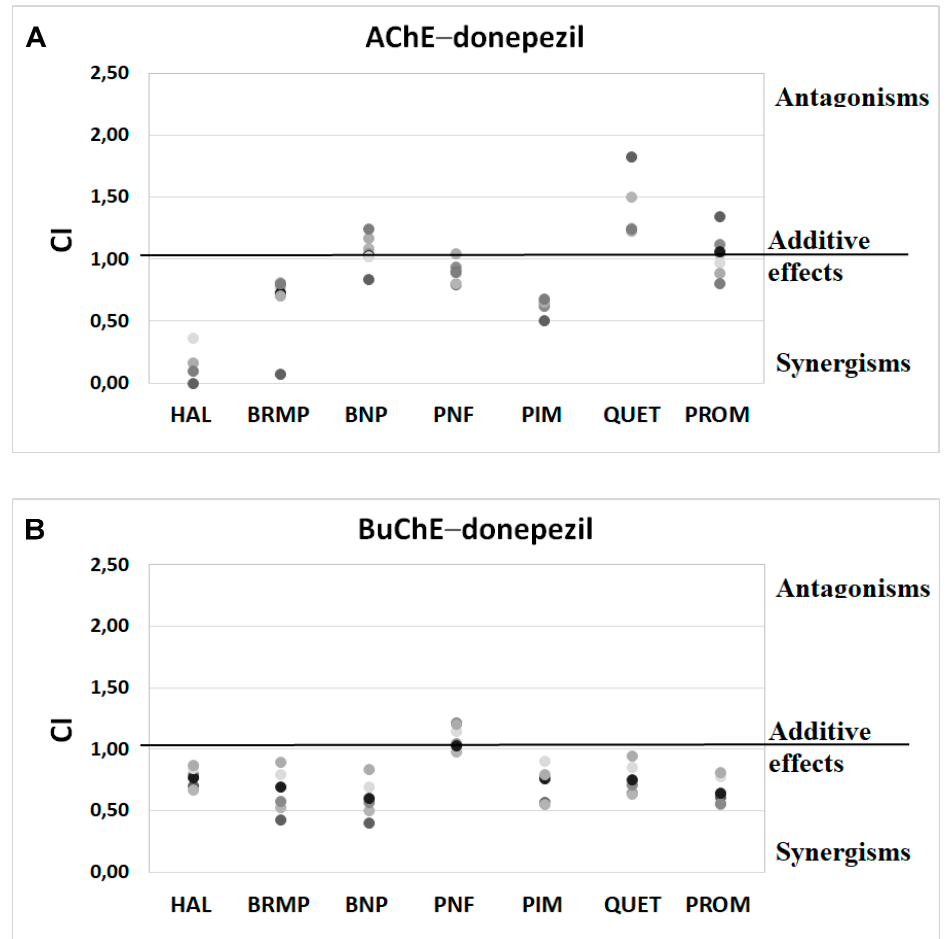
Figure 4. Analysis of potential synergism between donepezil (DON) and haloperidol (HAL), bromperidol (BRMP), benperidol (BNP), penfluridol (PNF), pimozide (PIM), quetiapine (QUET) and promazine (PROM) with the application of the median–effect principle. Data from an AChE ( A ) and BuChE ( B ) inhibitory activities assay were analyzed with the Chou–Talalay method. Results are presented as CI values determined with ComboSyn software for binary mixtures with variable concentration of donepezil (range 0.005–0.1 µmol/L for AChE and 2–100 for BuChE) and constant concentration of antipsychotic (at their TPC max ). The darker marker means higher concentration of DON in binary mix. The IC values for an individual concentration of DON are shown in Table S1 (Supplementary Materials). CI—combination index: where CI < 1, =1 and >1 indicate synergism, additive effect and antagonism, respectively. The values of CI of binary mixtures donepezil and rivastigmine with tested antipsy- chotics are included in the Supplementary Materials (Tables S1 and